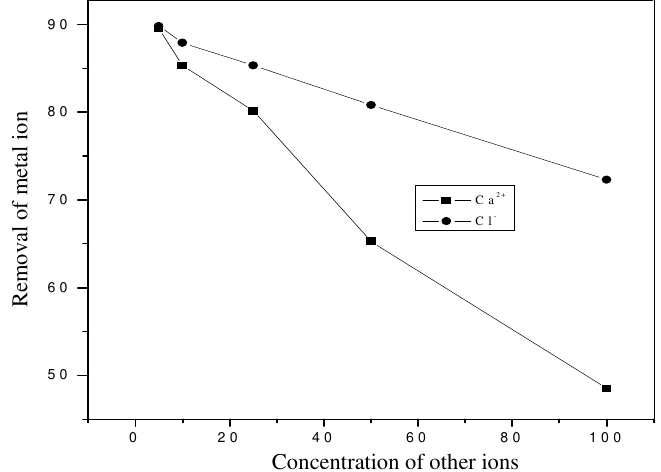
Figure 6. Effect of other ions on the adsorption of chromium ion.